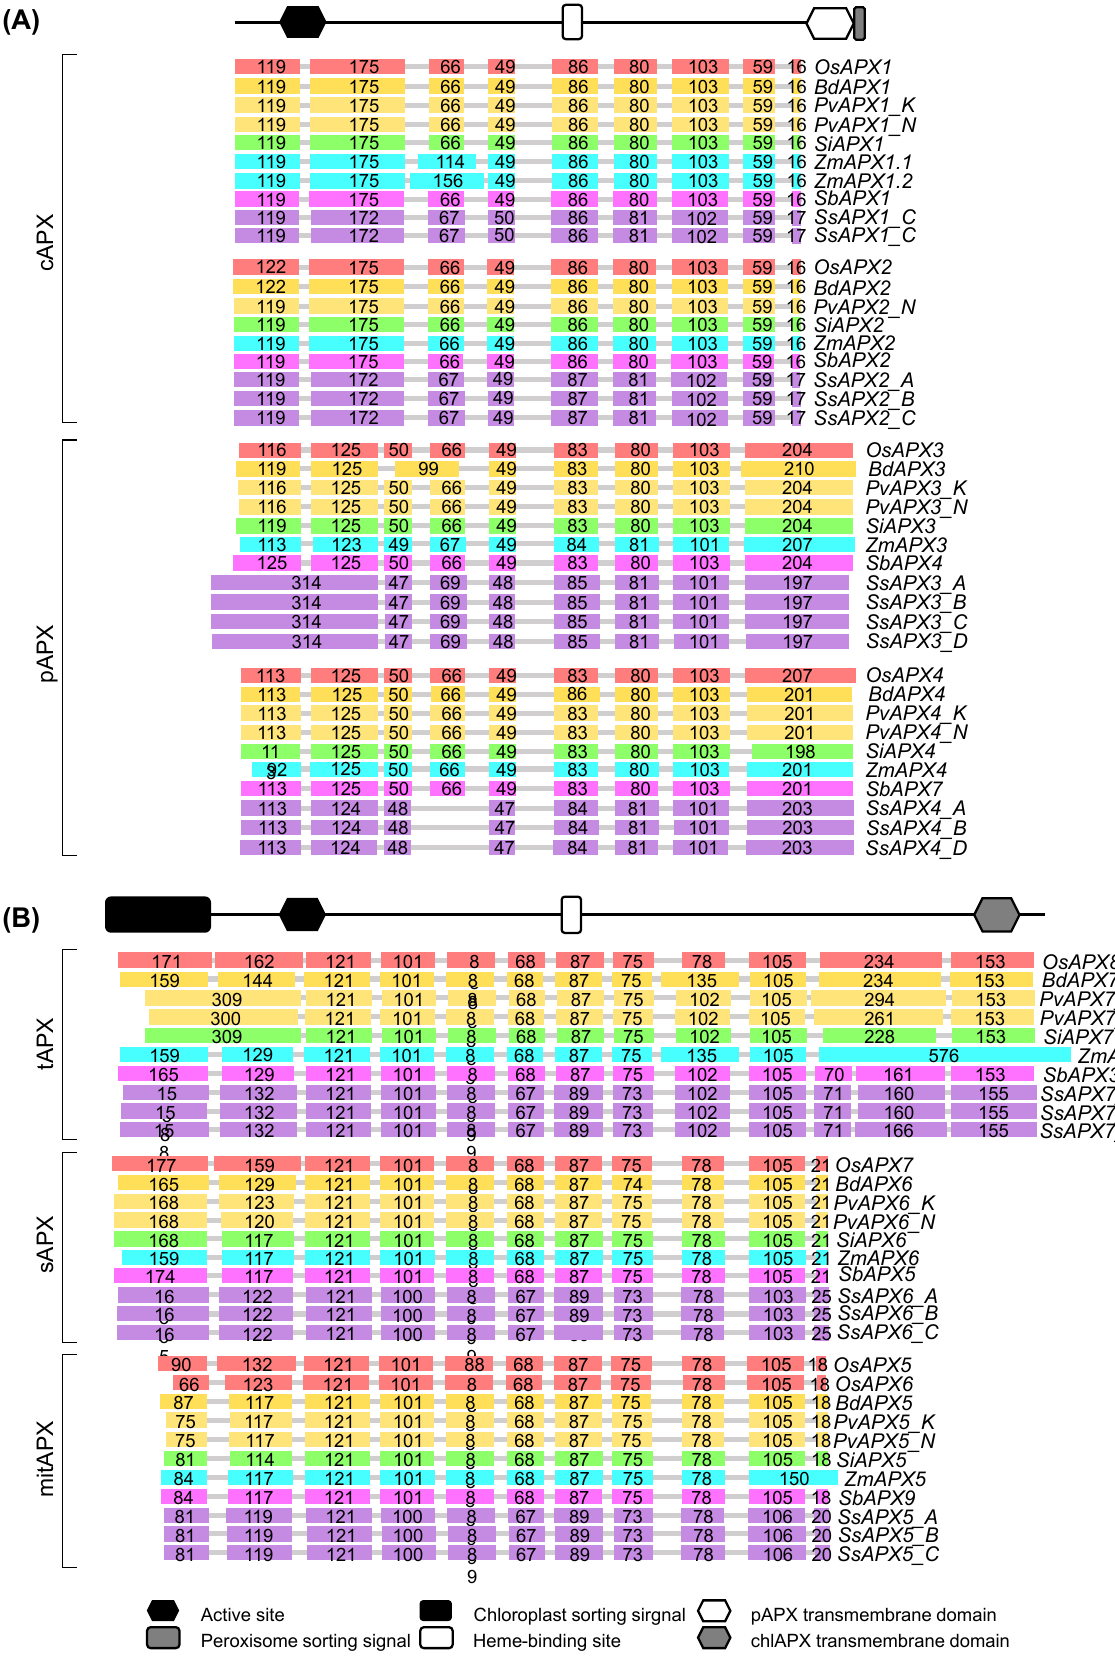
Figure 4 – Exon-intron structure APX genes from Oryza sativa , Brachypodium distachyion , Panicum virgatum , Setaria italica , Zea mays , Sorghum bicolor and Saccharum spontaneum (A) cAPX and pAPX, and (B) tAPX, sAPX and mitAPX. For all genes, grey lines represent introns and the lengths of exons are exhibited